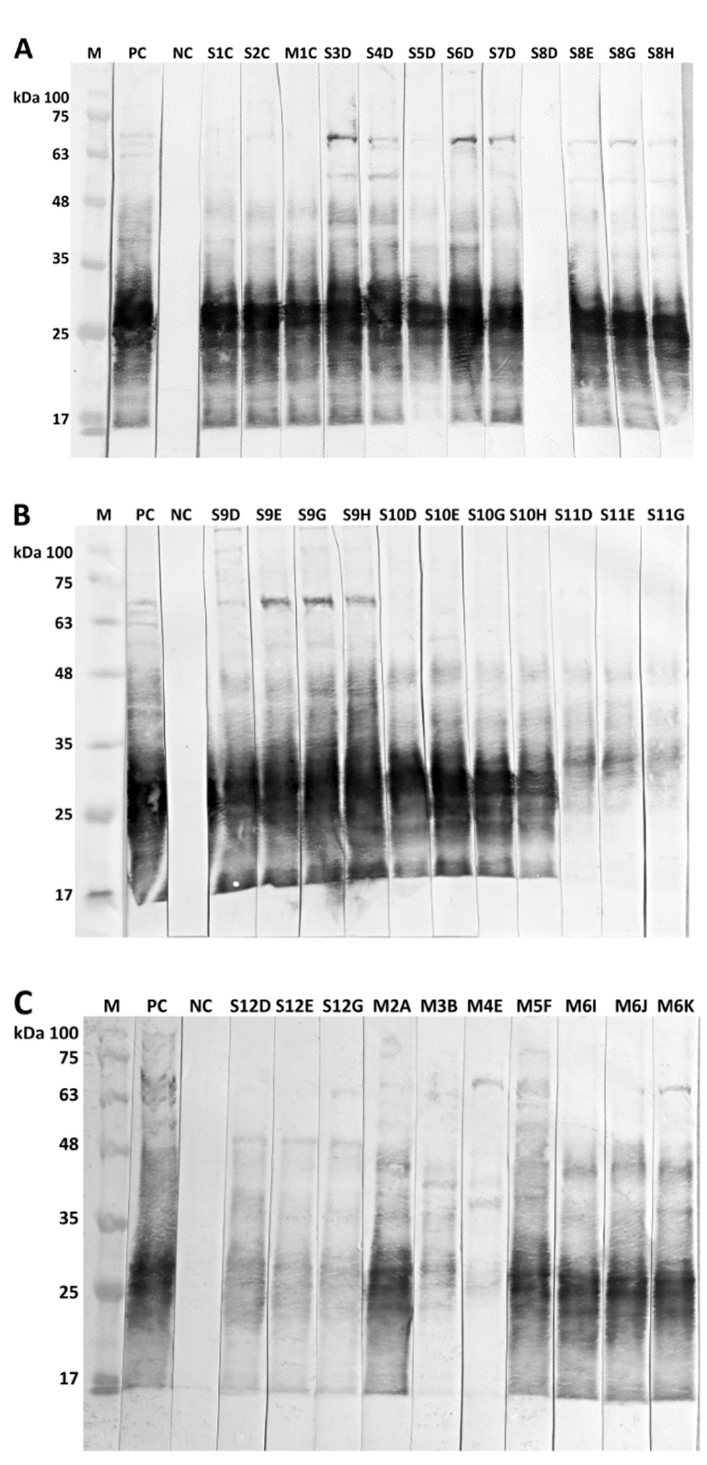
Figure 2. Immunoblot analyses of 33 blood samples originating from 17 alpacas for detection of antibodies against C. pseudotuberculosis . See Table 1 for details on the alpacas. Immunoblot ( A ) Stallions S1–S8, mare M1; Immunoblot ( B ) Stallions S9–S11; Immunoblot ( C ) Stallion S12, mares M2–